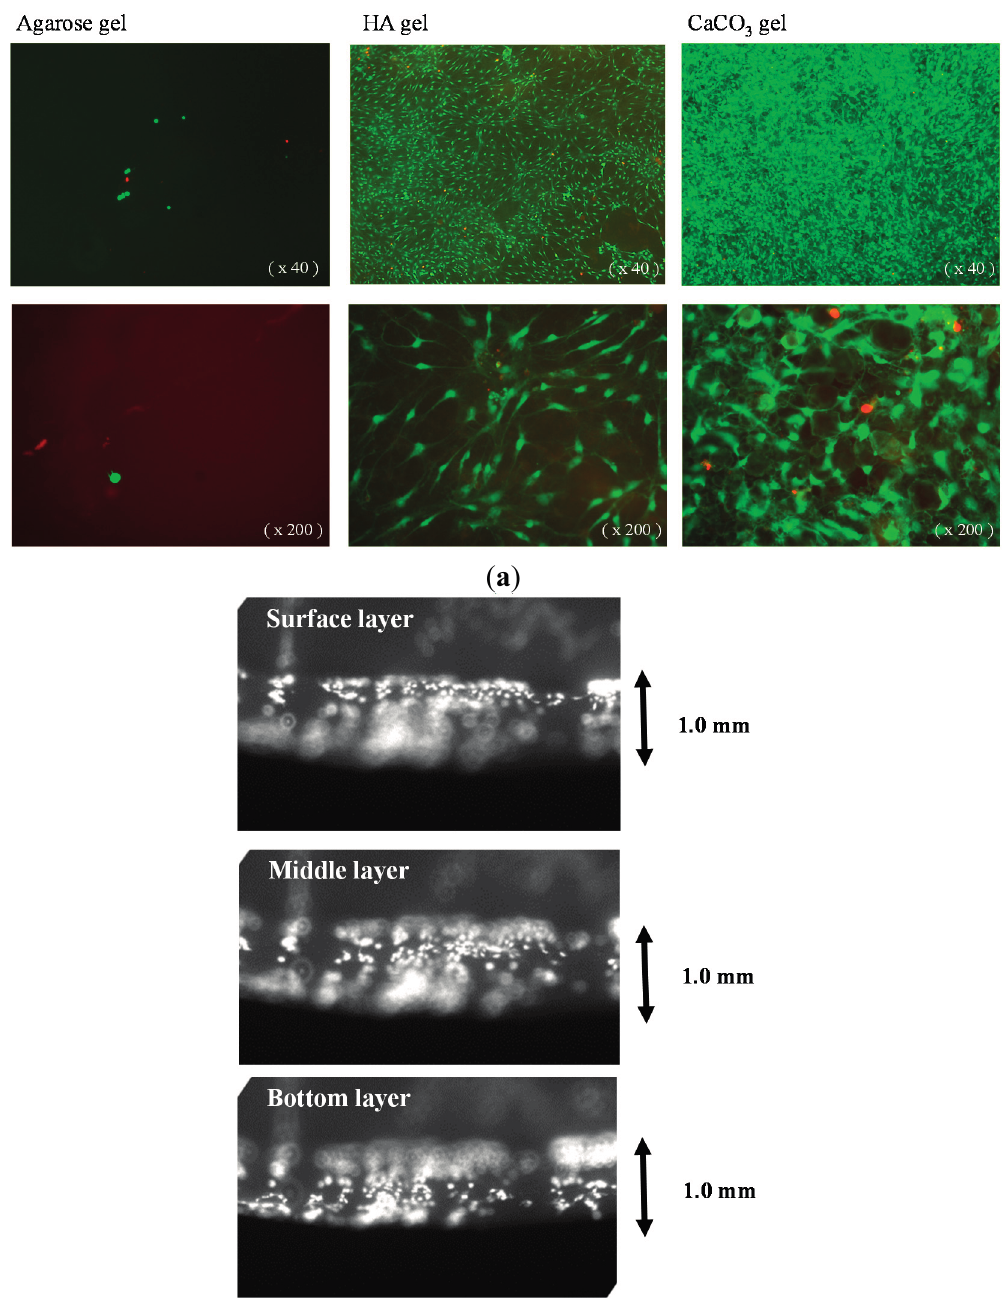
Figure 1. ( a ) Fluorescence microscope images of mesenchymal stem cells (MSCs) cultured for 16 days on agarose, hydroxyapatite (HA)/agarose, and CaCO 3 /agarose gels with live/dead stain. Left panels: Agarose gel; middle panels: HA/agarose; right panels: CaCO 3 /agarose gel. The lower panels show high-power magnification (200×) images of the upper panels (40×). Disk shaped gels with 1.0-mm thickness and 10-mm diameters; ( b ) Fluorescence microscope images of MSCs cultured for 21 days on the HA/agarose gel with live/dead stain. The cultured gel was cut perpendicular to the round surface of the gel at its center. The cross-section was observed under the microscope by focusing surface to bottom layer. Disk shaped gels with 1.0-mm thickness and 10-mm